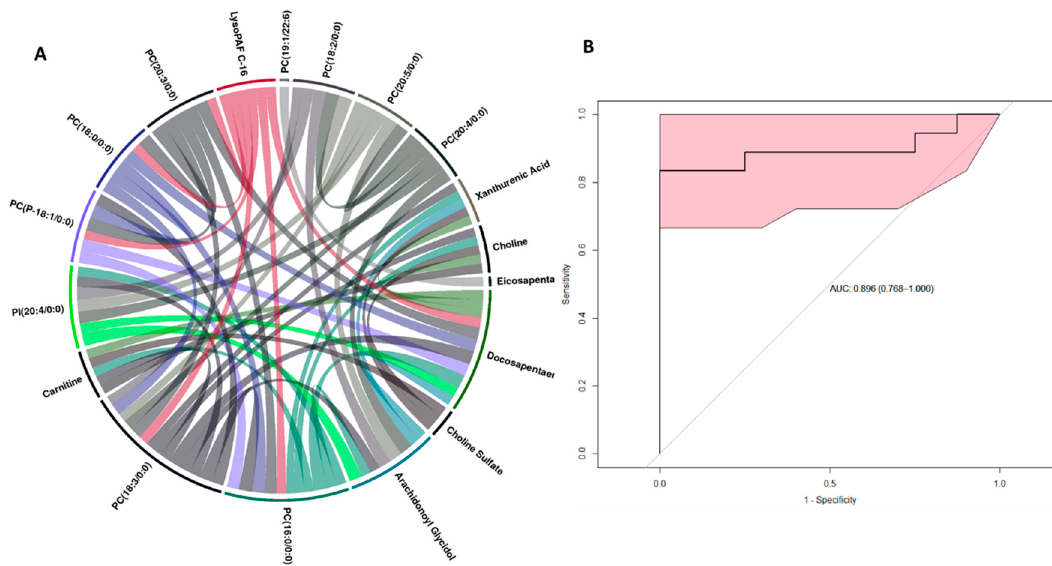
six-metabolite panel that included PE 16:0 / 18:1, SM (16:1 / 17:0), xanthine, N-lactoyl-phenylalanine, Sphinganine, PE (16:0 / 20:4) was able to discriminate healthy and surviving NHPs by > 90% predictive accuracy (Figure 5, Panel B). Int. J. Mol. Sci. 2019 , 20 , x FOR PEER REVIEW